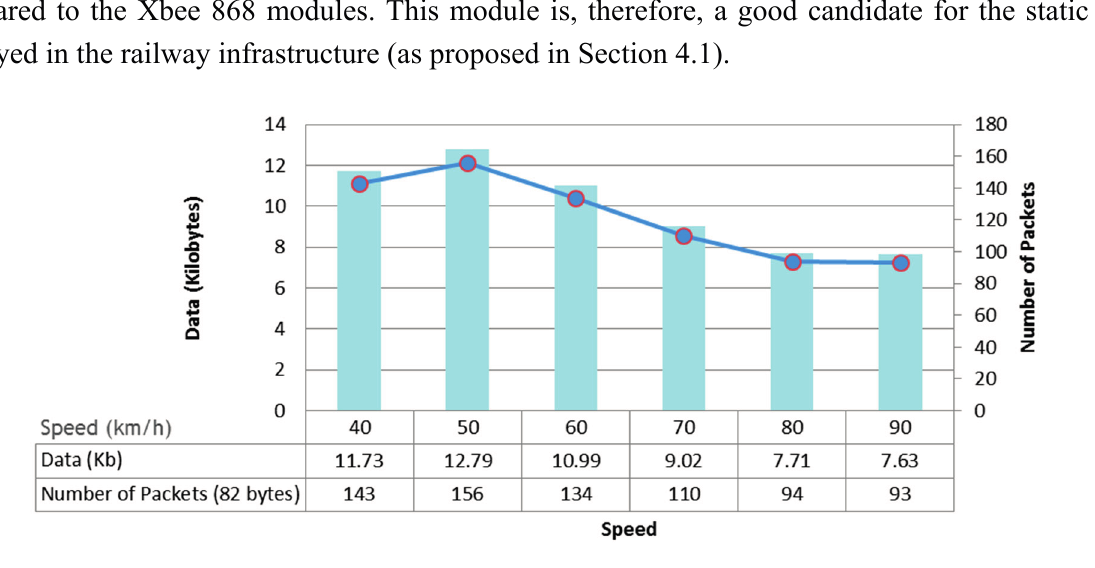
Figure 13. Results of the transmission and mobility tests (2.4 GHz and 2 dBi